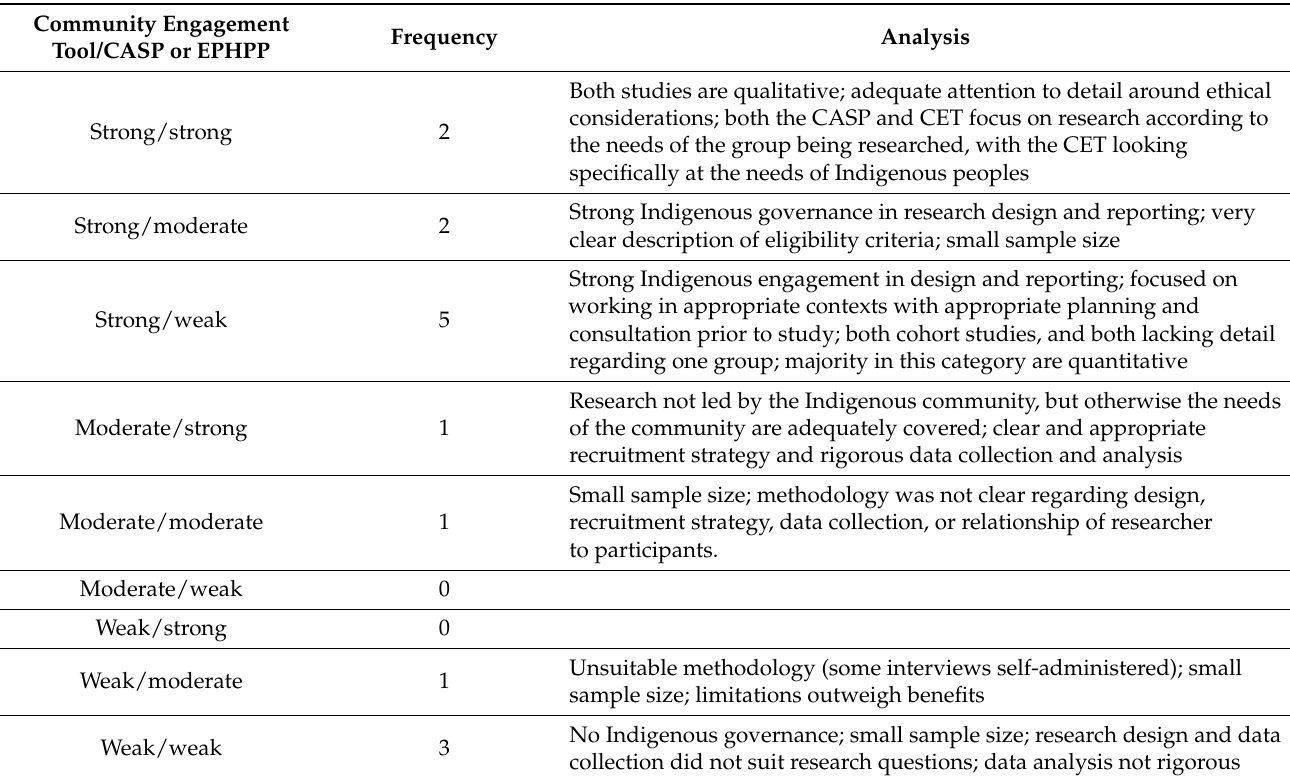
Table 3. Frequency and summary of